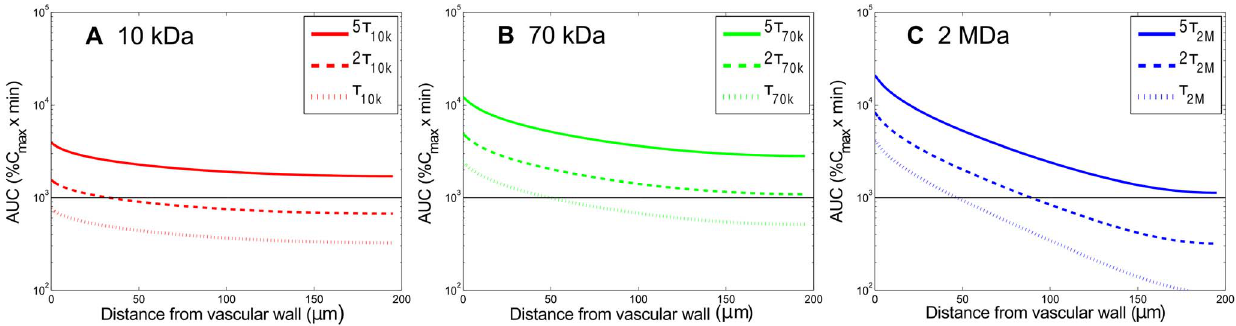
Figure 7. Effect of the plasma half-life time of carriers on the spatial distribution of accumulative exposure. The effect of the plasma half-life time of carriers on the spatial distribution of accumulative exposure (up to 0 : 5% C max ). The horizontal lines show the value of AUC equal to 1000 % C max | min . The permeability and interstitial diffusivity in this case are listed in Table 1 corresponding to each molecular weight.